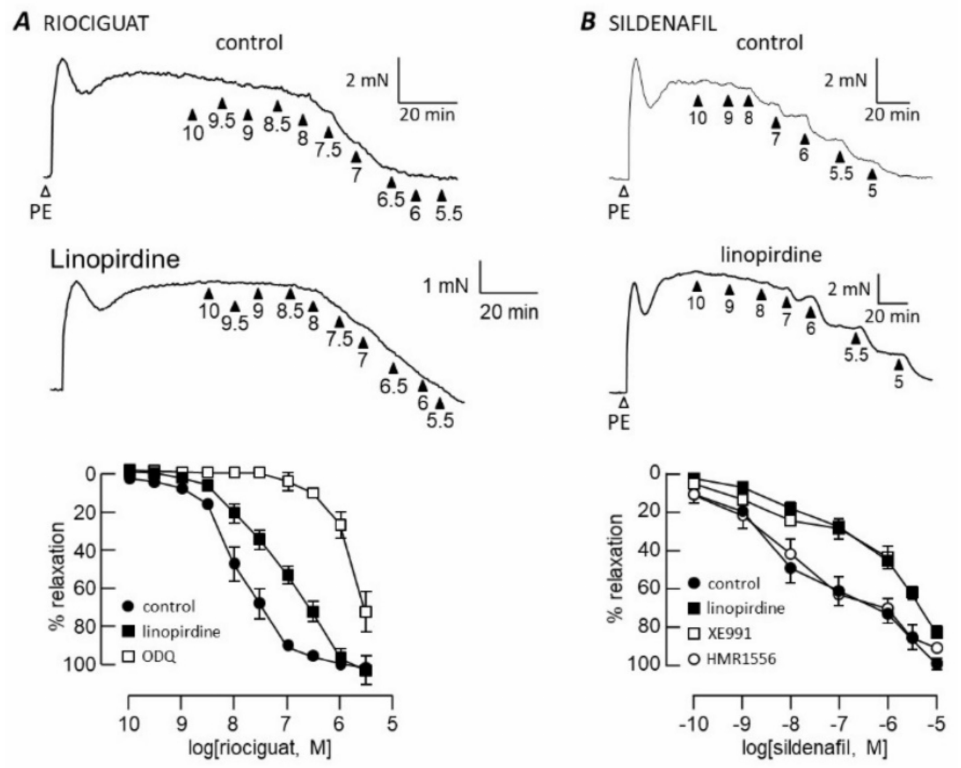
Figure 2. Kv7 channel blockers inhibit cGMP-dependent relaxation. Traces illustrate pulmonary artery contraction to 1 µ M phenylephrine (PE), followed by relaxation responses to increasing concentrations of riociguat ( A ) or sildenafil ( B ) applied cumulatively in control conditions (upper traces) and after incubation with 1 µ M linopirdine (lower traces). Arrowheads indicate − log[dilator]. Concentration–response curves (bottom panel) are plotted in control conditions and after incubation with 1 µ M Kv7 blocker as indicated. Riociguat n = 5 (control and linopirdine) or 3 (ODQ); sildenafil n = 4 (HMR1556 and XE991), 10 (control) or 11